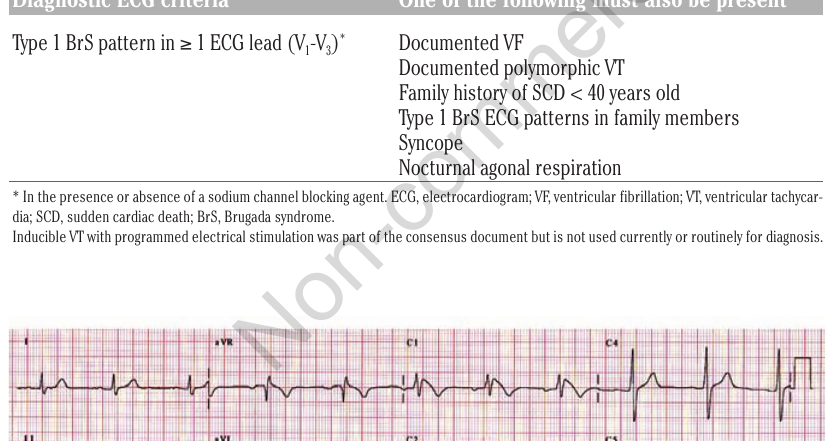
Table 1. Diagnostic criteria for the Brugada syndrome. Diagnostic ECG